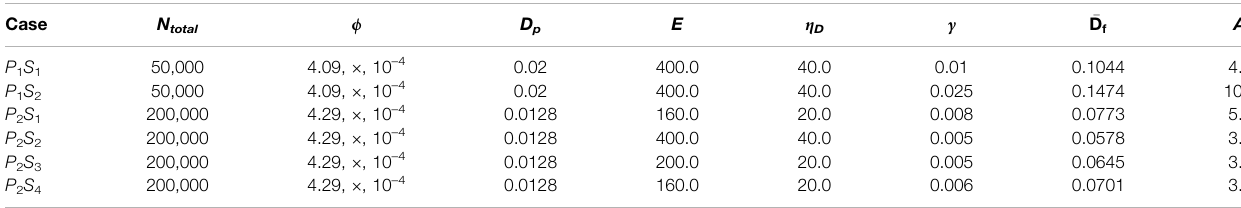
TABLE 1 | Summary of parameters for all simulations, all parameters are normalized. (cid:2) D f is the average fl oc size at the equilibrium state and Ad represents the adhesive number. Case